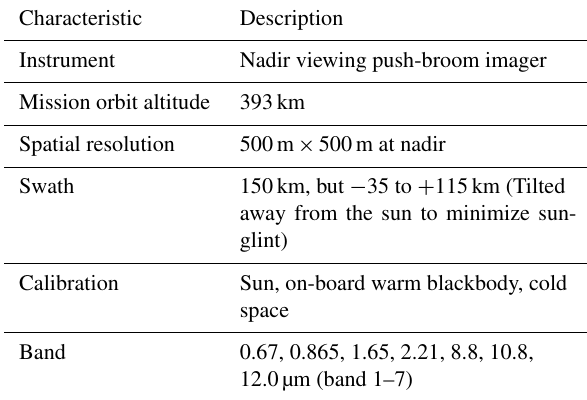
Table 1. General characteristics of EarthCARE